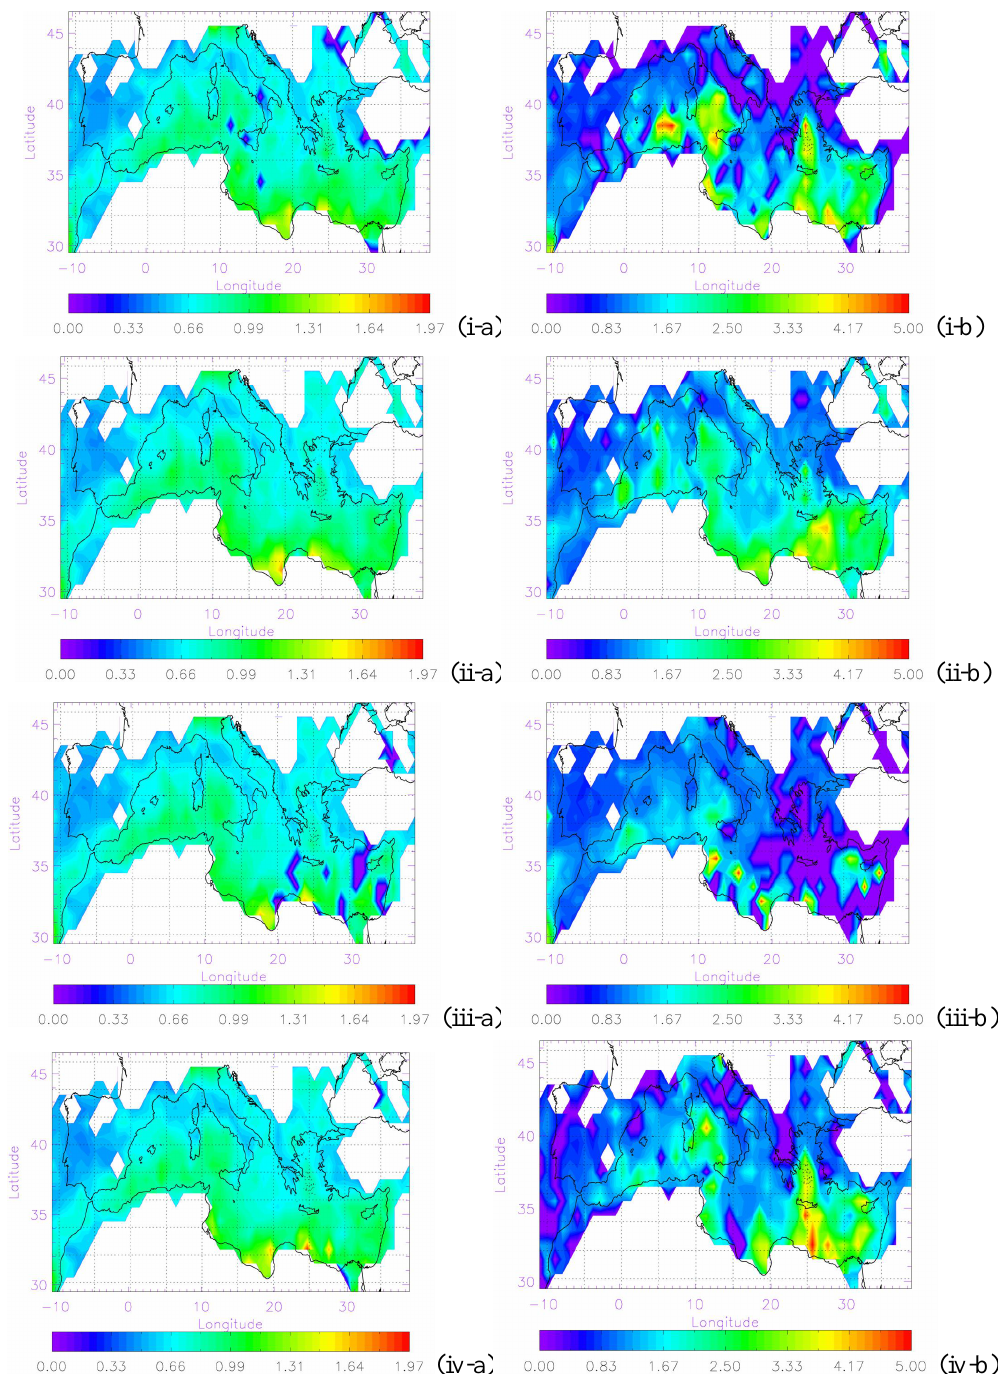
Fig. 5. As in Fig. 4 but for: (i) winter, (ii) spring, (iii) summer and (iv) autumn. Columns (a) and (b) show the results for strong and extreme aerosol events,